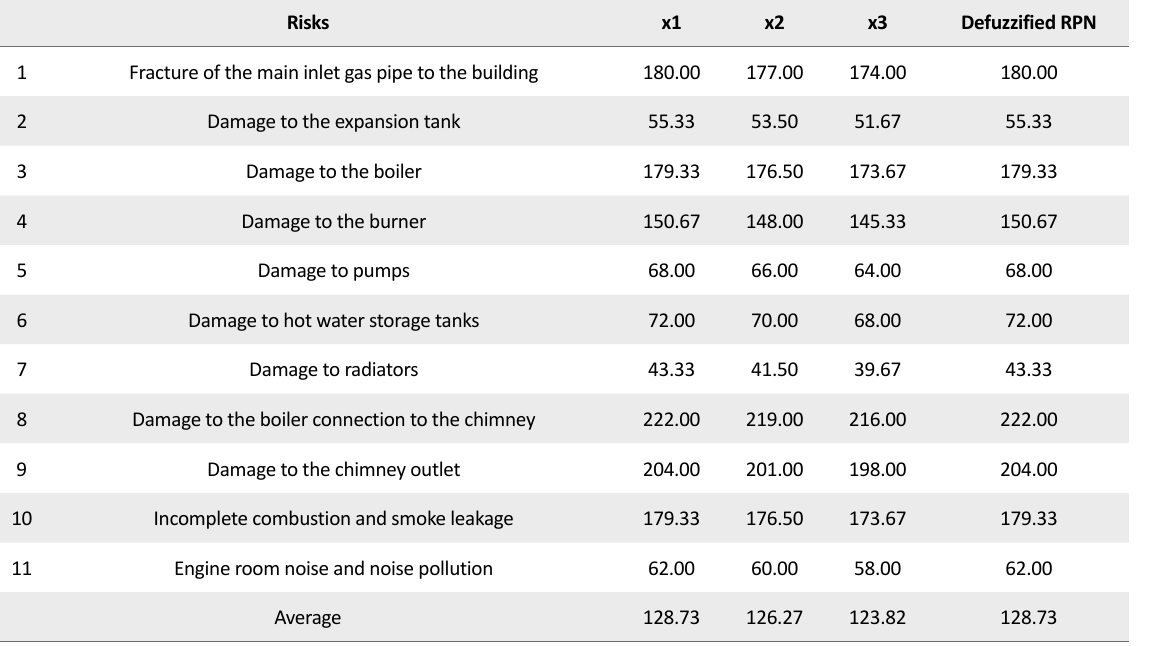
Table 8. Defuzzified RPN values for the risk of CHBRs